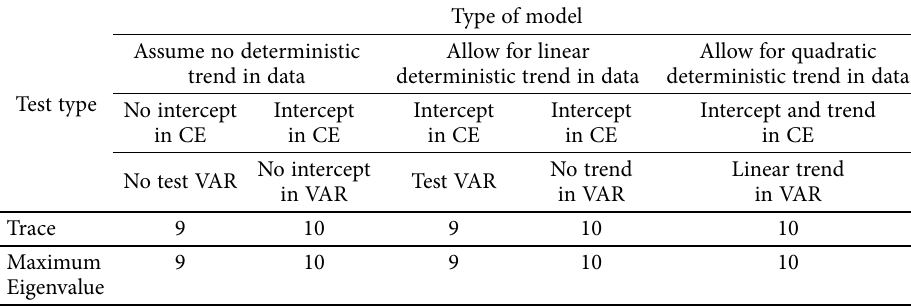
Table 1. Number of cointegrating relations by model